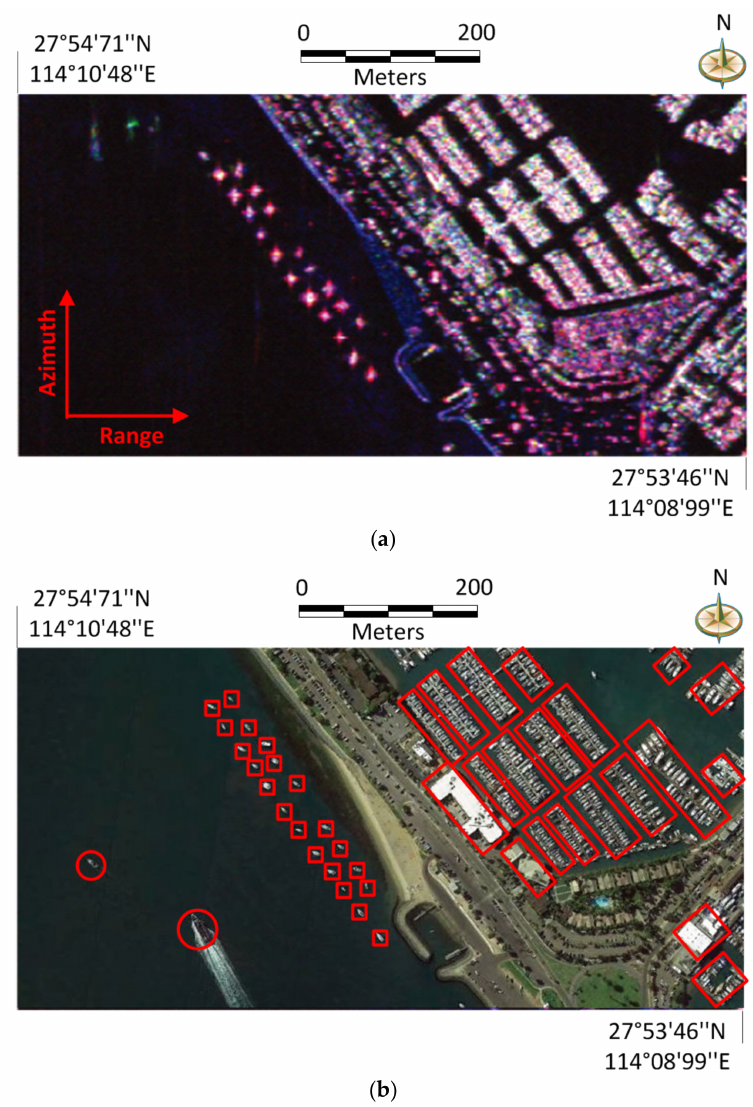
Figure 10. Third study area and UAVSAR dataset. ( a ) Pauli-coded image with L-band (red: HH − VV, green: HV, blue: HH + VV); ( b ) Optical image from Google Earth. The areas with red rectangles represent targets of